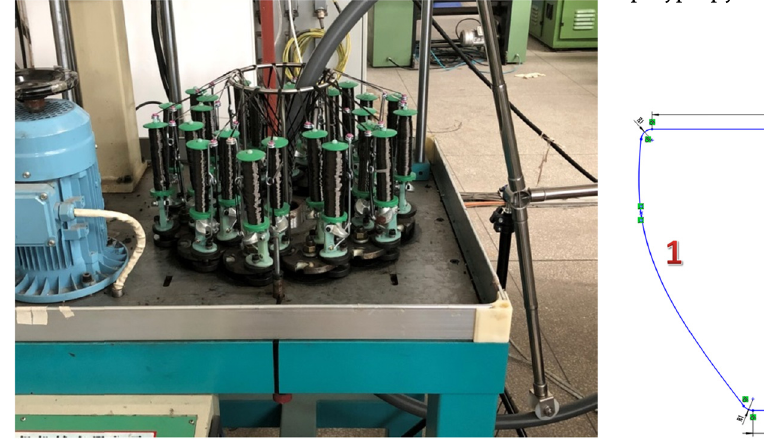
Figure 2: Actual image of the annular axis braiding machine. Figure 3: Schematic diagram of cross section of the